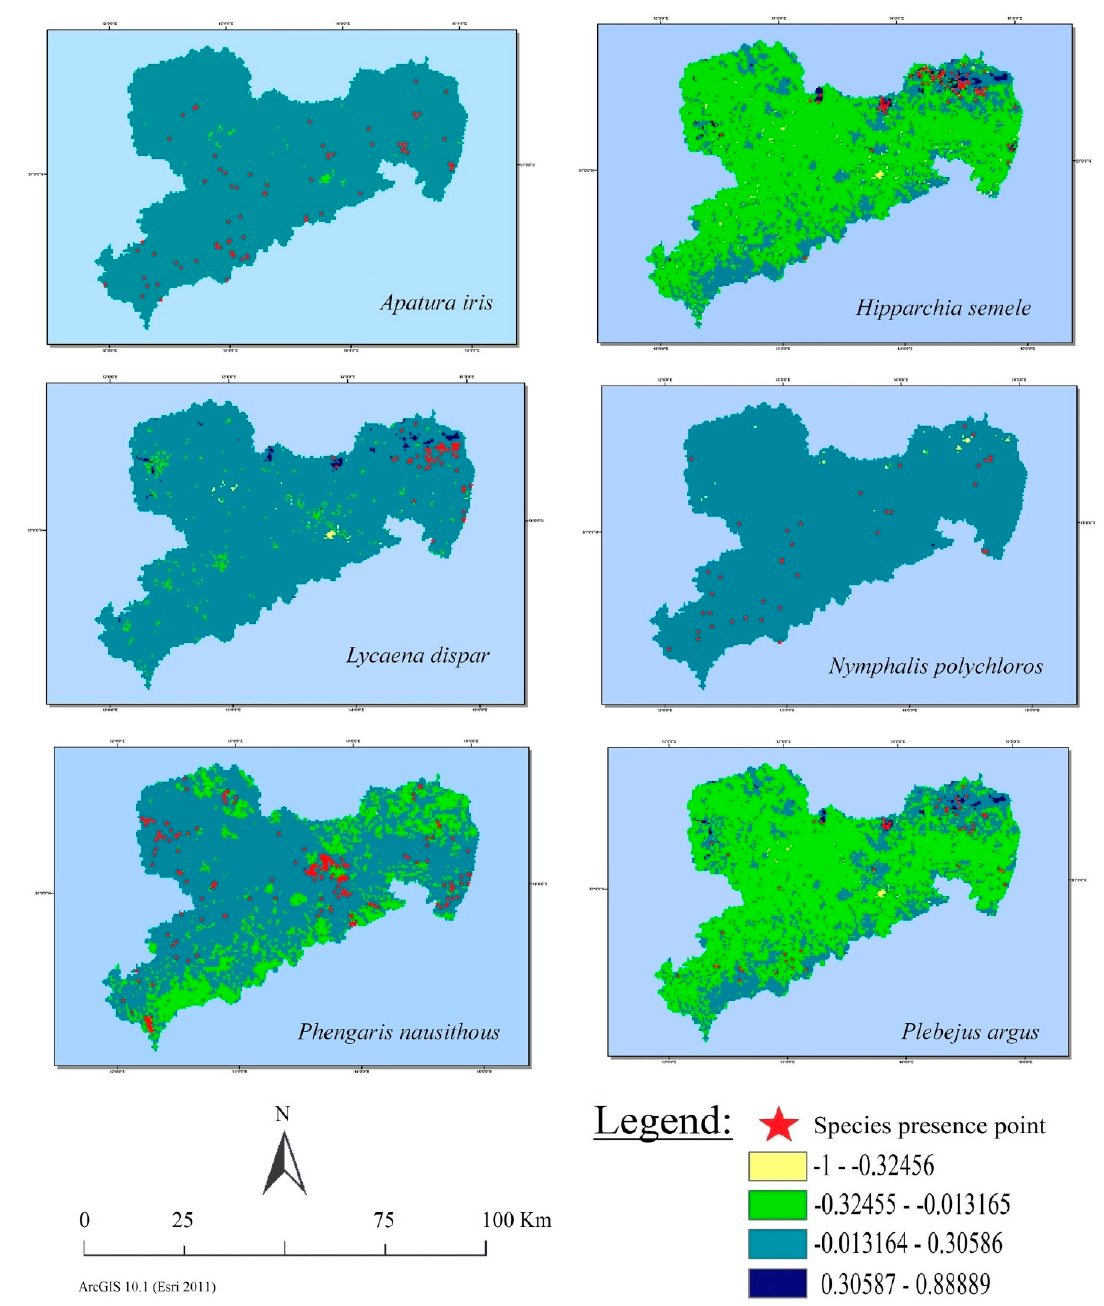
Figure 2. Maps of habitat preference based on IEI occup for all six species (IEI values towards − 1.0 indicate avoidance while +1.0 represents suitable).